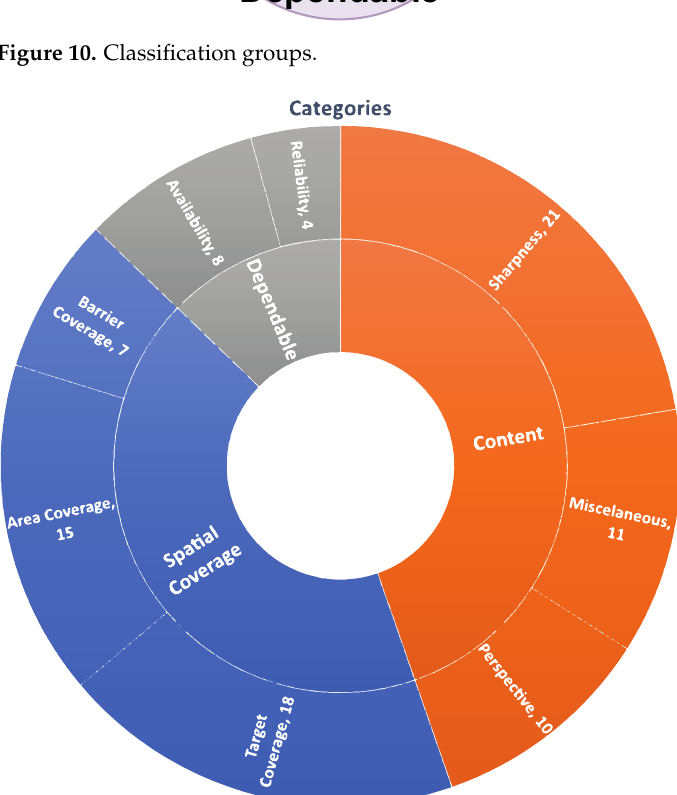
Figure 11. Distribution of the groups and